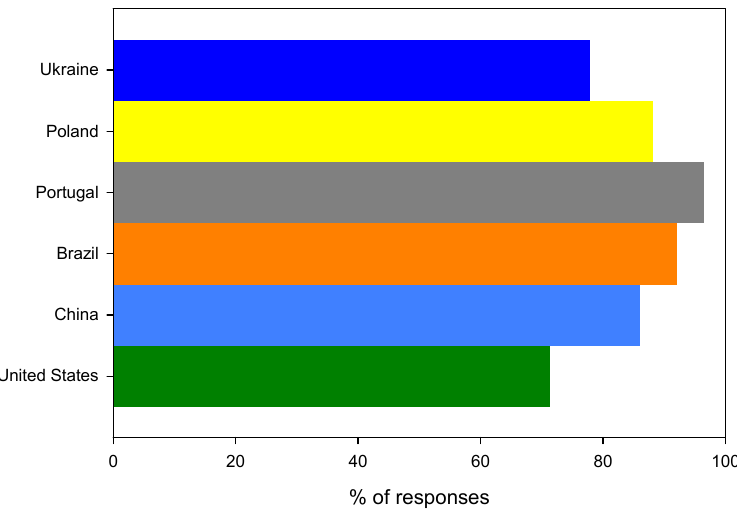
Figure 10. The distribution of positive answers to the question: Would you share the knowledge about such packaging with others?